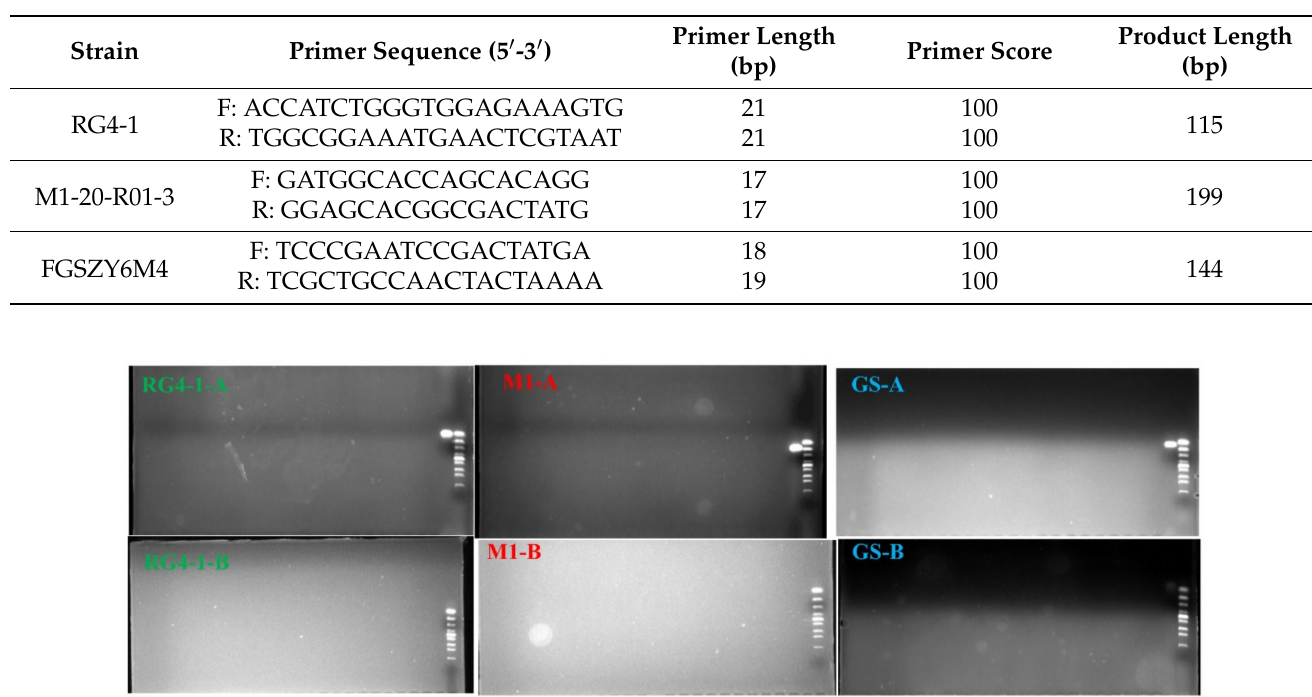
Table 7. Strain-specific primers for three B. longum strains.